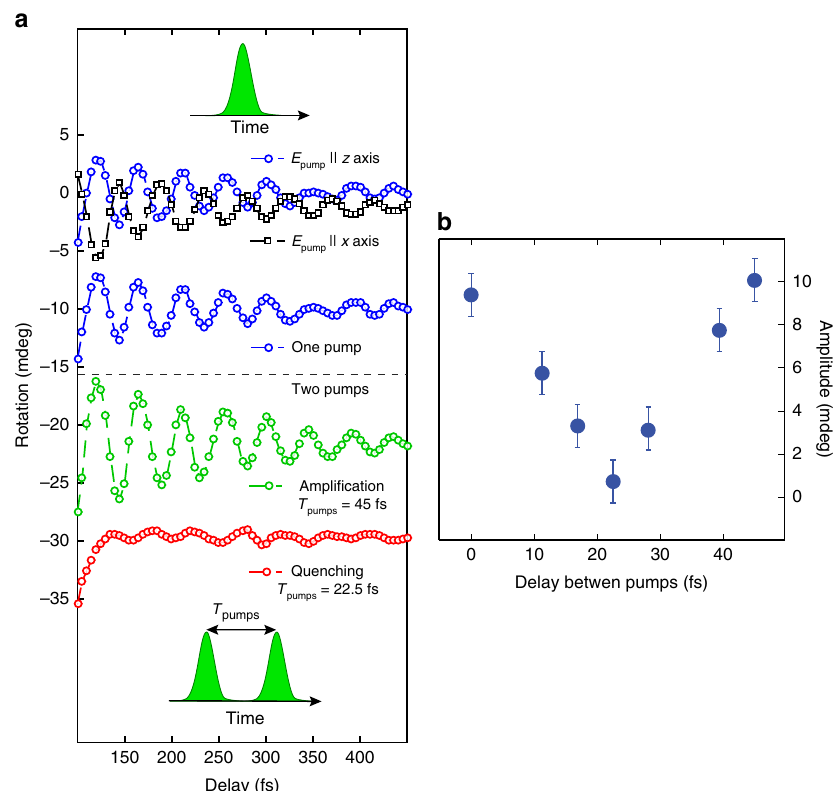
Figure 4 | Coherent control of the spin dynamics. ( a ) The blue and black dotted traces were obtained using a single-pump beam linearly polarized along the z axis (blue circles) and the x axis (black squares). The phase of the oscillations is shifted by p . The single-pump measurement is repeated for the sake of comparison with the results of the double-pump experiments. The green-circle data set was observed by delaying two pump pulses by T pumps ¼ 45fs, that is, the period of the 2M mode. The coherent amplification of the signal is observed. The coherent oscillations were quenched, when the delay between the two pump pulses was set to T pumps ¼ 22.5fs. The fluence of both pump beams was set to E 1.5mJcm (cid:2) 2 . The temperature was 80K. The probe beam was polarized along the x axis. ( b ) Amplitude of the first oscillation as a function of the delay between the two pumps ( T pumps ), the periodic trend is clear. The error bars are defined as twice the sensitivity of our